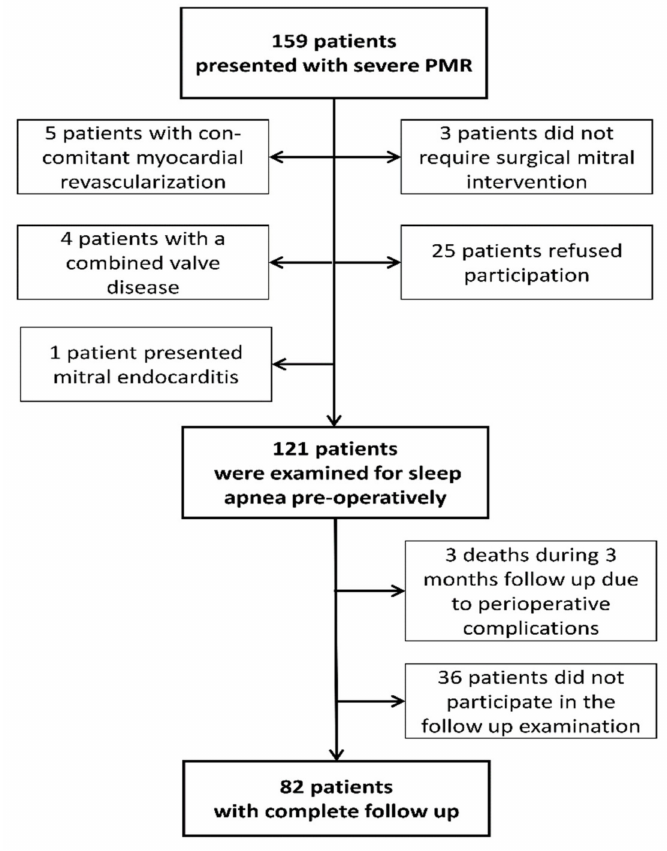
Figure 1. Patient Enrollment and Follow-up. PMR: primary mitral regurgitation. Table 1. Baseline Characteristics of the